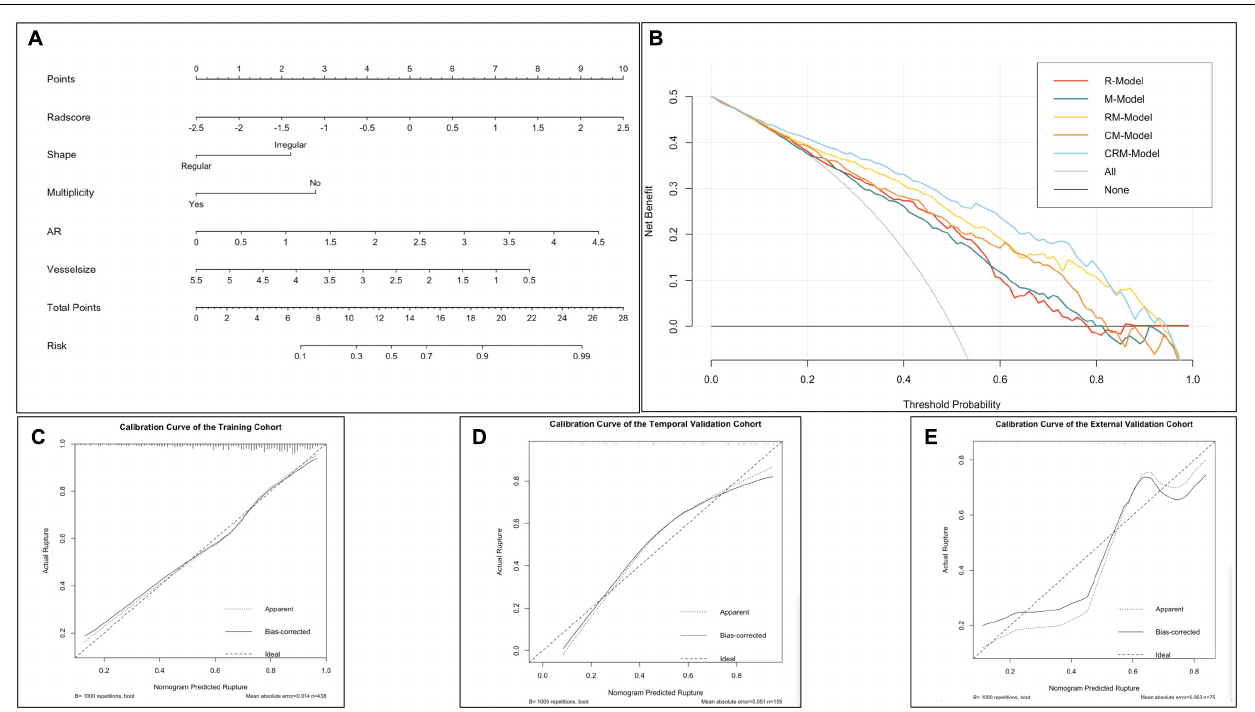
FIGURE 3 | The comprehensive nomogram for classifying ruptured MCA aneurysm and decision curve analysis in the overall patients. (A) The comprehensive nomogram for predicting aneurysm rupture. (B) Decision curve analysis in overall patients. The y -axis indicates the net benefit; the x -axis indicates threshold probability. The gray line represents the assumption that all aneurysms rupture. The black line represents the assumption that no aneurysm ruptures. The red line, green line, gold line, orange line, and blue line represent the net benefit of the radiomics model (R-model), morphological model (M-model), radiomics-morphological model (RM-model), clinical-morphological model (CM-model), and clinical-radiomics-morphological model (CRM-model), respectively. Calibration of the nomogram in the training (C) , temporal validation (D) , and external validation datasets (E)